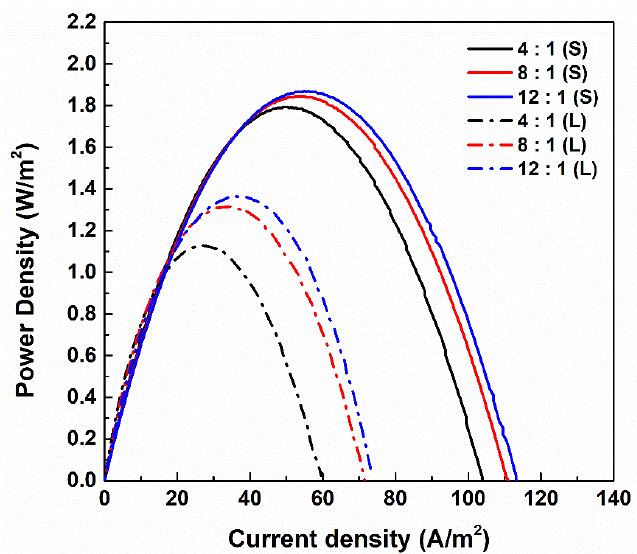
Figure 2. Gross power density of large and small RED stacks according to the composition of pore ‐ filling ion exchange membranes (PIEM). “S” and “L” indicate the results obtained from small and large RED stacks,